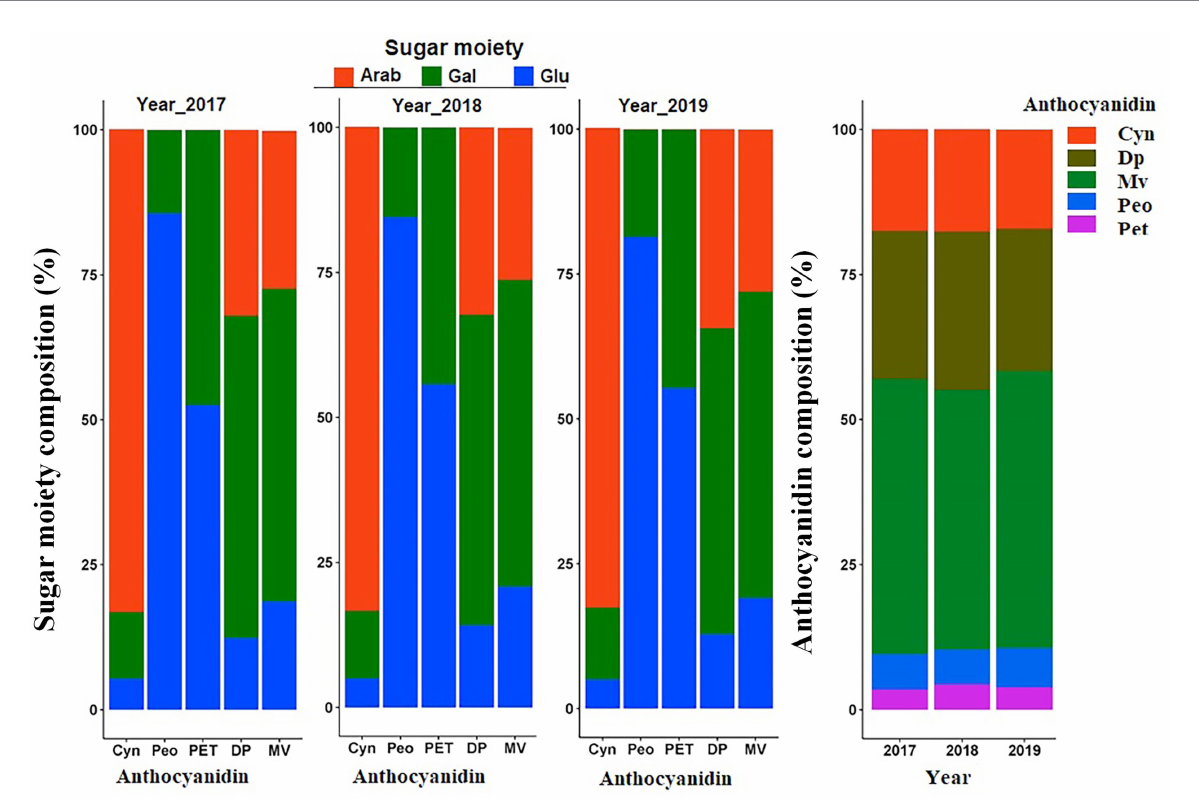
FIGURE 3 Anthocyanin composition variation. Average composition of each sugar moiety to the respective anthocyanidin group, and average anthocyanidin composition relative to the totalANC in the mapping population over 3